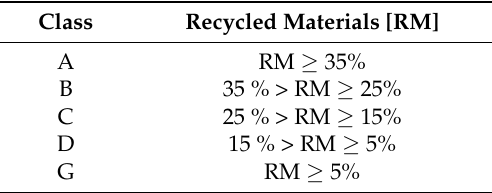
Table 2. Rating systems for assessing the RM